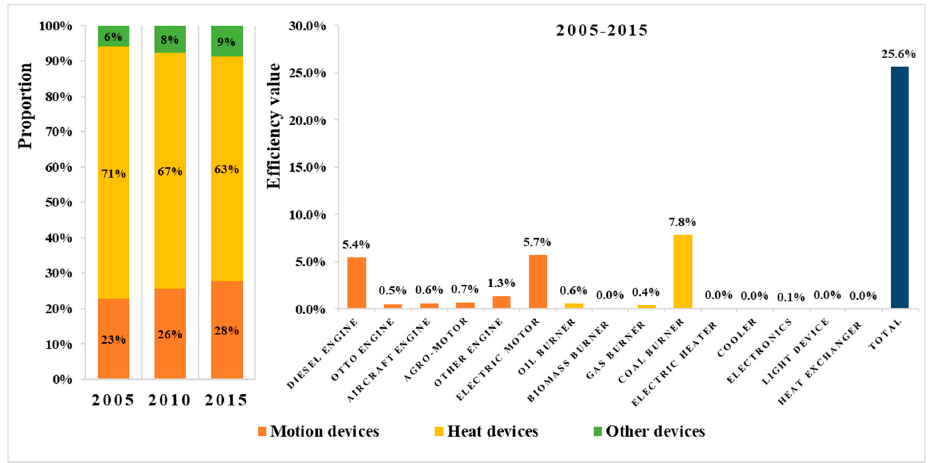
Figure 10. The proportion of the end-use structure in China from 2005 to 2015 (Left); Relative contributions of efficiency improvements of conversion devices in China from 2005 to 2015 (Right).